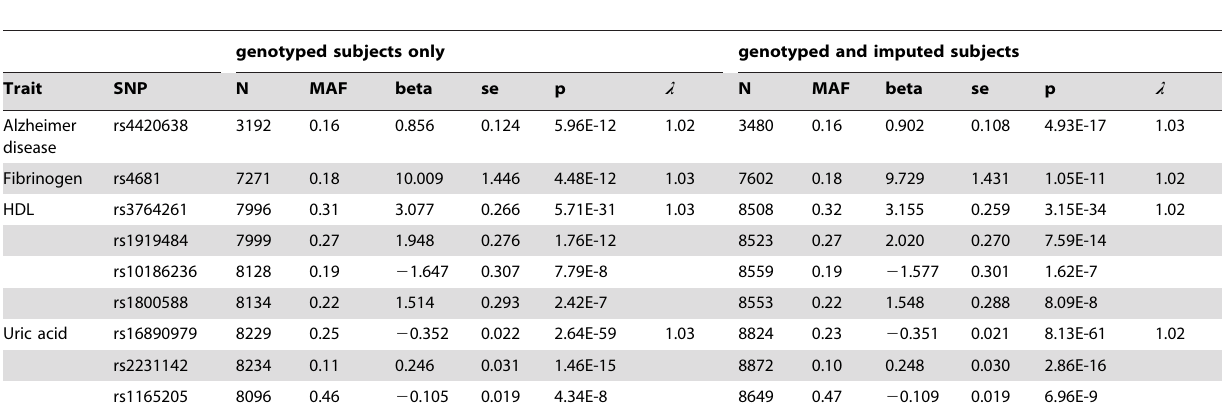
Table 3. Results of top SNPs (p-value , 1.25E-7) from GWAS of Alzheimer disease, fibrinogen, HDL and uric acid using 550K genotype data and incorporated genotype data.